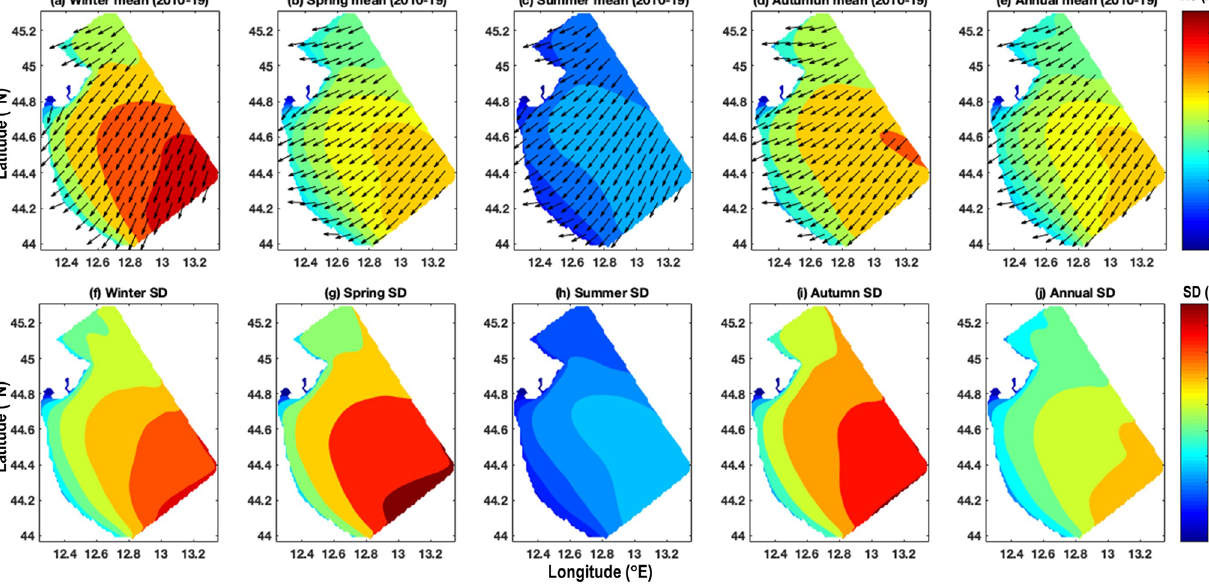
Figure 6. Wave climatology for the Emilia-Romagna region for 2010 to 2019. Mean significant wave height and direction for (a) winter, (b) spring, (c) summer, (d) autumn, and (e) annual (top panels). The lower panels show the standard deviation (SD) of wave height for (f) winter, (g) spring, (h) summer, (i) autumn, and (j) annual periods.